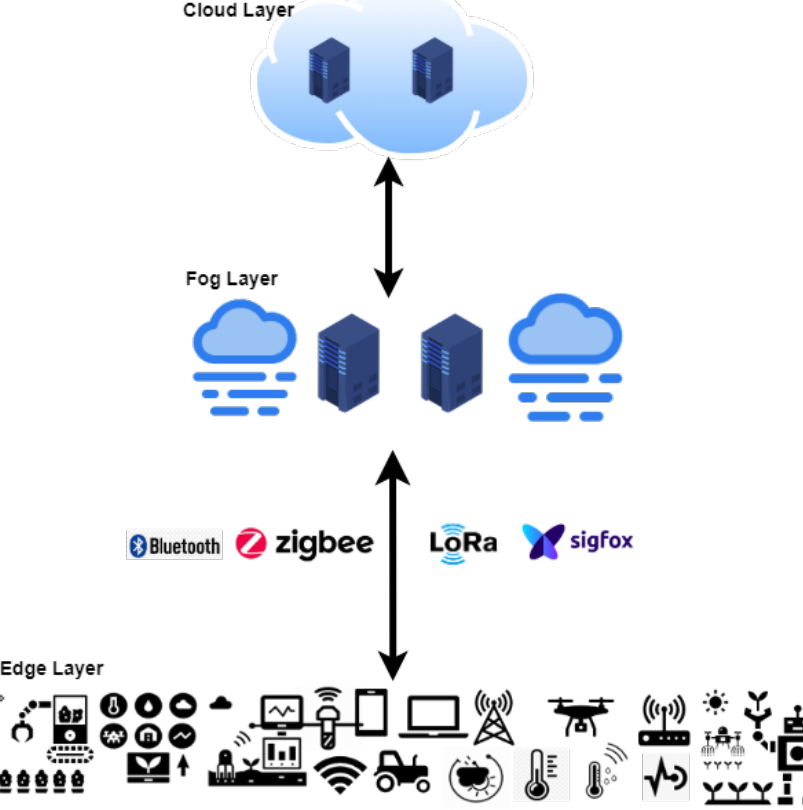
Figure 4. Three layered architecture for smart